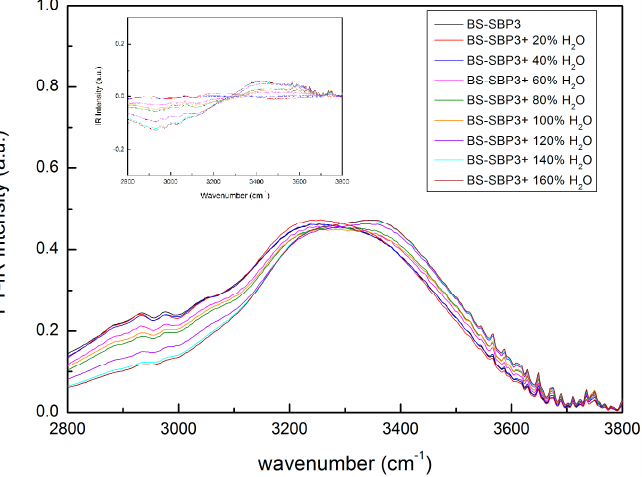
Figure 6. Infrared spectra of the intramolecular O-H-stretching bands collected for BS-SBP3 aqueous solutions at different water contents. In the inset, the difference between the hydrated BS-SBP3 spectra and the anhydrous BS-SBP3 spectrum at different concentration values is reported.